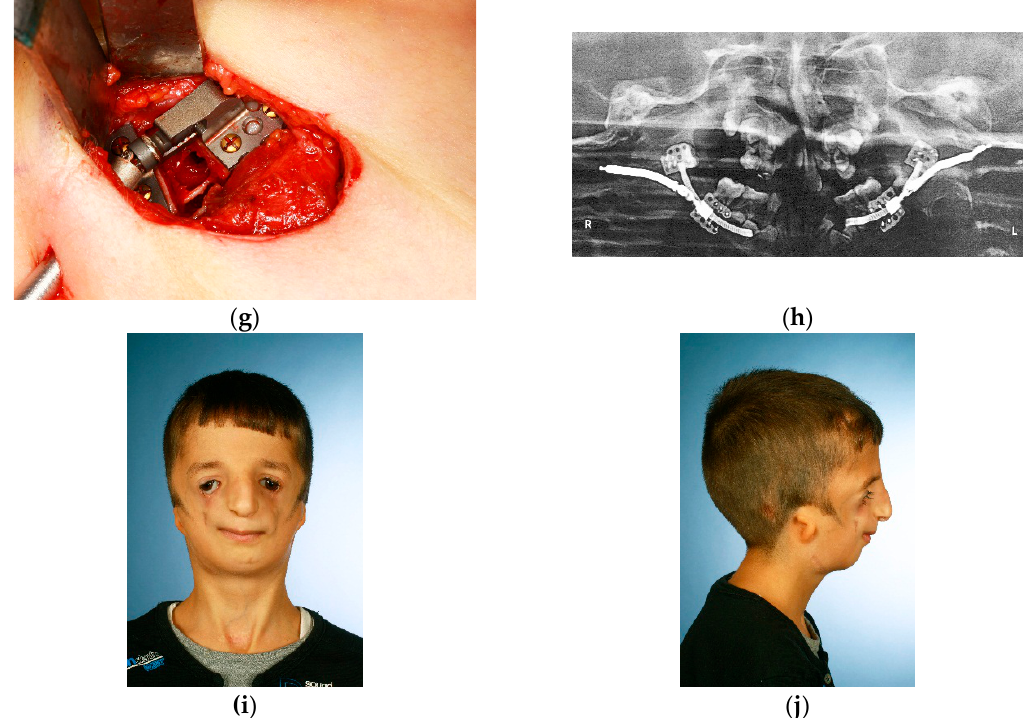
Figure 4. ( a , b ) Preoperative situation in a seven ‐ year old boy affected by Treacher ‐ Collins ‐ Syndrome, due to airway impairment tracheostomy was present since the first year of life; ( c , d ) Virtual planning of mandibular reconstruction by curvilinear distraction; ( e – g ) Intraoperative situations; ( e ) distraction device adapted to the mandible, ( f ) corresponding cutting guides in place for piezo ‐ assisted osteotomy, ( g ) intraoperative activation of the distraction device demonstrating the intact neurovascular bundle; ( h ) Radiological situation at the end of distraction (bilateral activation of 20 mm); ( i , j ) Clinical situation one year after computer ‐ assisted lower facial reconstruction by bilateral curvilinear mandibular